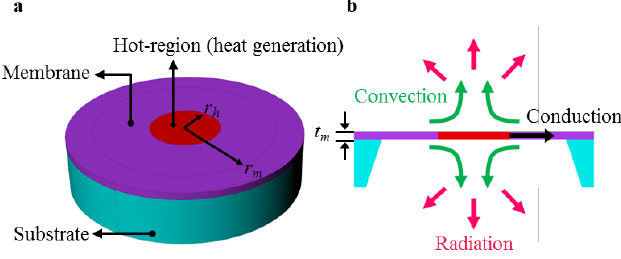
Figure 1. Schematic diagram for a circular-symmetric micro-hotplate and the corresponding heat flows. Perspective view of the micro-hot-plate structure showing different parts ( a ); Cross-sectional view of the micro-hotplate structure with the description of the three heat transfer mechanisms ( b ).